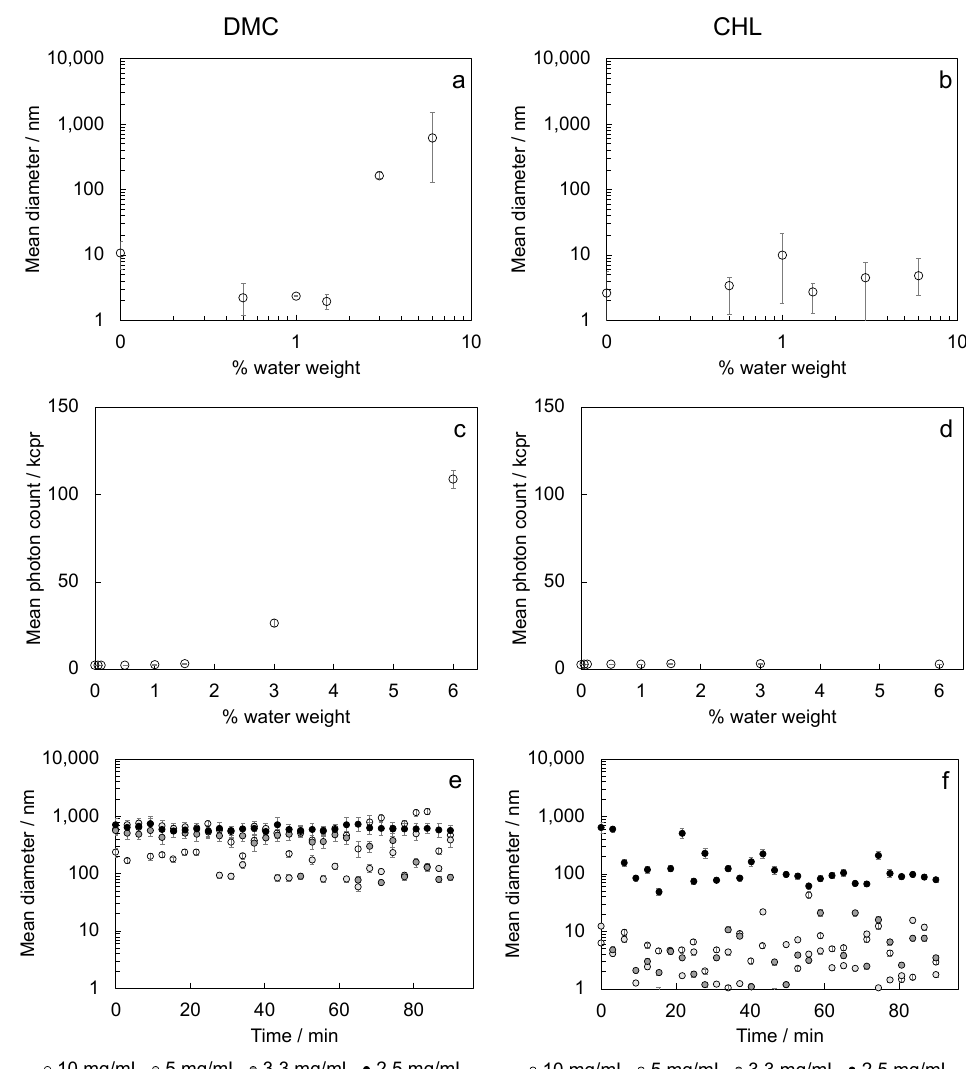
Figure 2. Preliminary analysis performed to select the best solvent for preparation of reversed micelles: evaluation of water vesicles in the selected solvent by varying the percent water weight (( a ) DMC, ( b ) CHL); mean photon counts obtained in water vesicles measurements (( c ) DMC, ( d ) CHL); preliminary evaluation of suitable polymer concentrations by measuring the size of vesicles/micelles formed during time (( e ) DMC, ( f ) CHL).